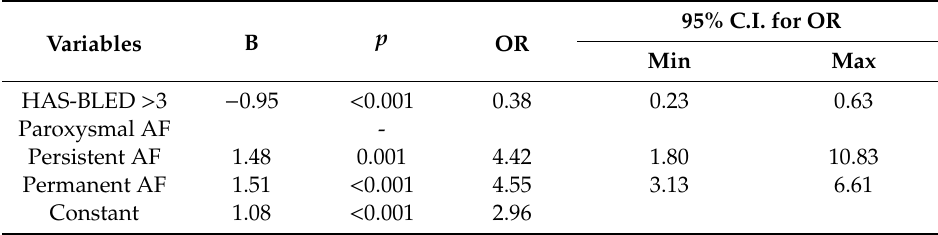
Table 4. Multivariate analysis for the OAC